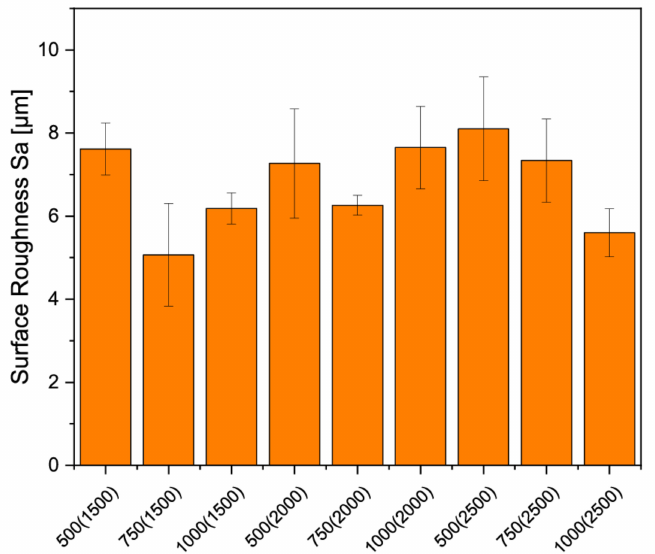
Figure 6. Overview of the surface roughness of the different scaffolds, the measurements were carried out on the Keyence 3D laserscanning microscope